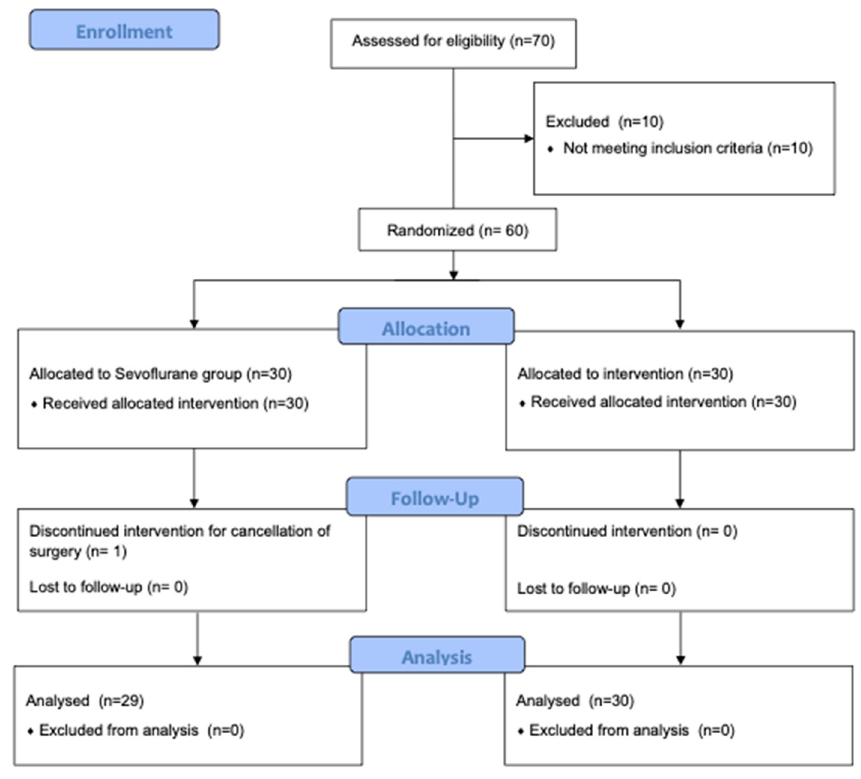
Figure 1. CONSORT diagram showing the flow of participants through each stage of the randomized trial. Table 1. Patient characteristics.